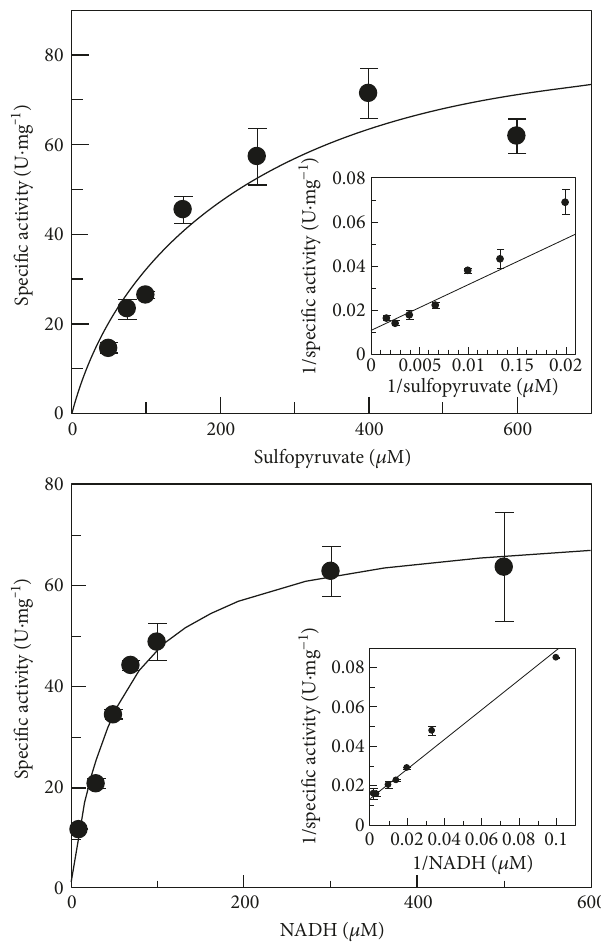
Figure 3: Michaelis-Menten plots for ComC. Michaelis-Menten plots were used to calculate kinetic parameters. The respective Lineweaver-Burk plots are inset. Standard assay conditions in the reduction reaction were used; 400mM KCl, pH 6.5, and 37 ° C. Assays were carried out in triplicate. One unit of activity (U) is de fi ned as the conversion of one μ mol of NADH to NAD + per minute under standard assay